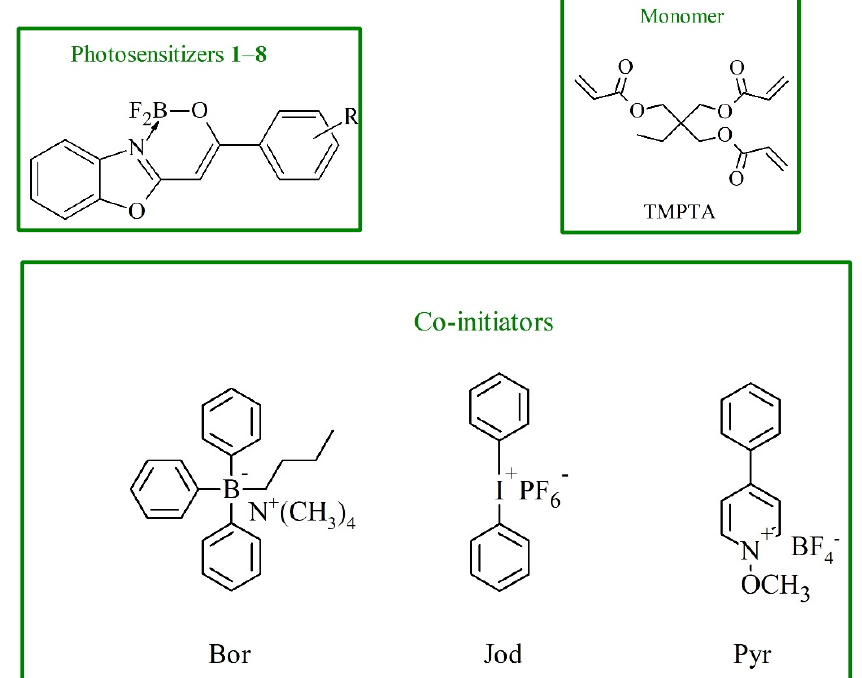
Figure 3. The composition of the polymerizing mixture.